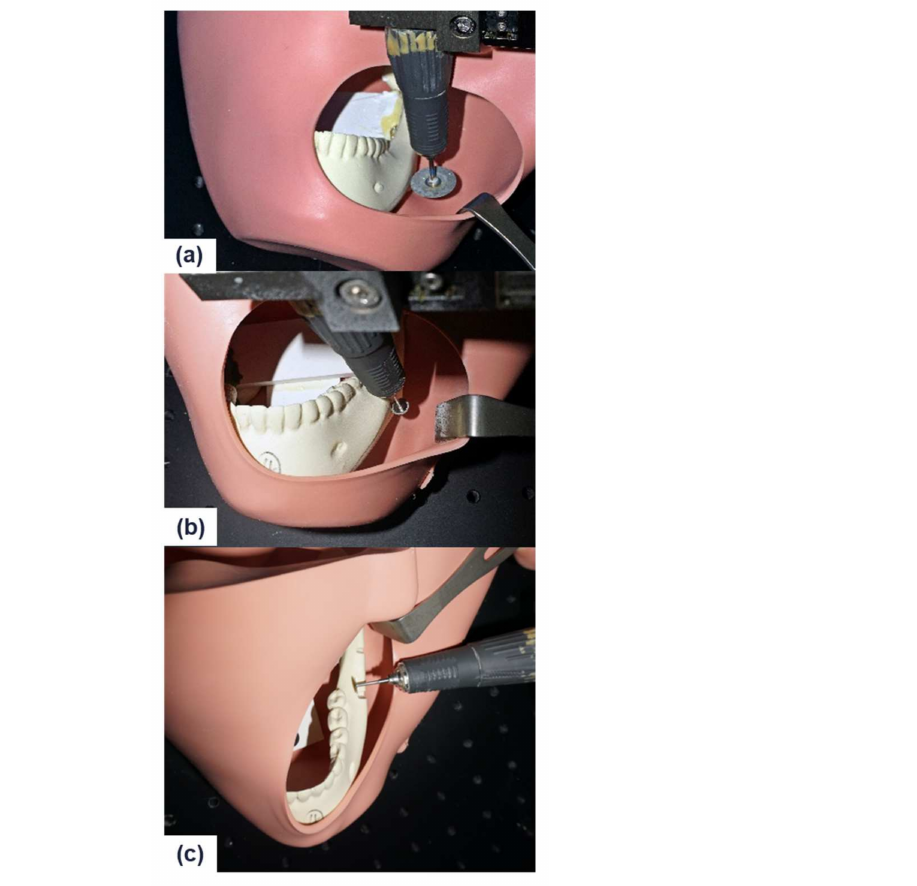
Figure 7. Test for the ease with which the posterior mandibular ramal area could be approached by the robot arm osteotomy through an intraoral approach in the dummy operating theater: inferior cut with 20 mm disc ( a ) and 6 mm disc ( b ), and superior cut with 6 mm disc ( c